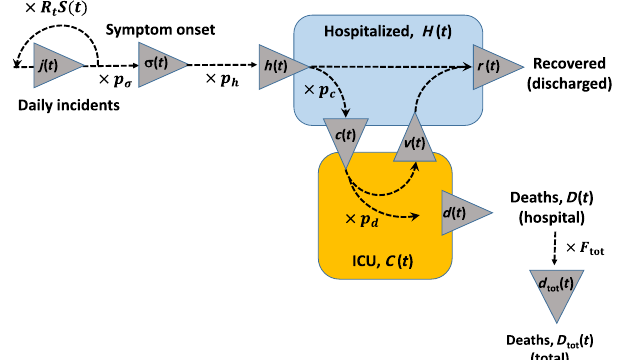
FIG. 1. Topology of our model, along with the names of all flux and state variables: the daily incidence, j i ð t Þ ; the daily number of newly symptomatic individuals, σ i ð t Þ ; the number of daily admissions to all hospitals, h i ð t Þ ; the daily number of patients discharged from all hospitals, r i ð t Þ ; the daily number of patients transferred from the main floor of a hospital to its ICU, c i ð t Þ ; the daily number of patients transferred from the ICU to the main floor of a hospital, v i ð t Þ ; the daily number of deaths in hospitals, d ð t Þ ; and the daily number of deaths in and out of hospitals, i d ð t Þ . State variables are as follows: the total number of tot ;i occupied hospital beds (main floor) H i ð t Þ and the total number of occupied ICU beds C i ð t Þ . The other parameters of the model are the fractions of infected individuals who become sympto- matic, p σ ;i ; the fraction of symptomatic individuals who are hospitalized, p h;i ; the fraction of hospital patients who get to ICU, p p c;i ; the fraction of ICU patients who will ultimately die, d;i ; and the multiplier, F , which converts between hospital deaths and tot all deaths in the state, including those outside of the hospital system. For the sake of legibility, we suppress age-group indices in the